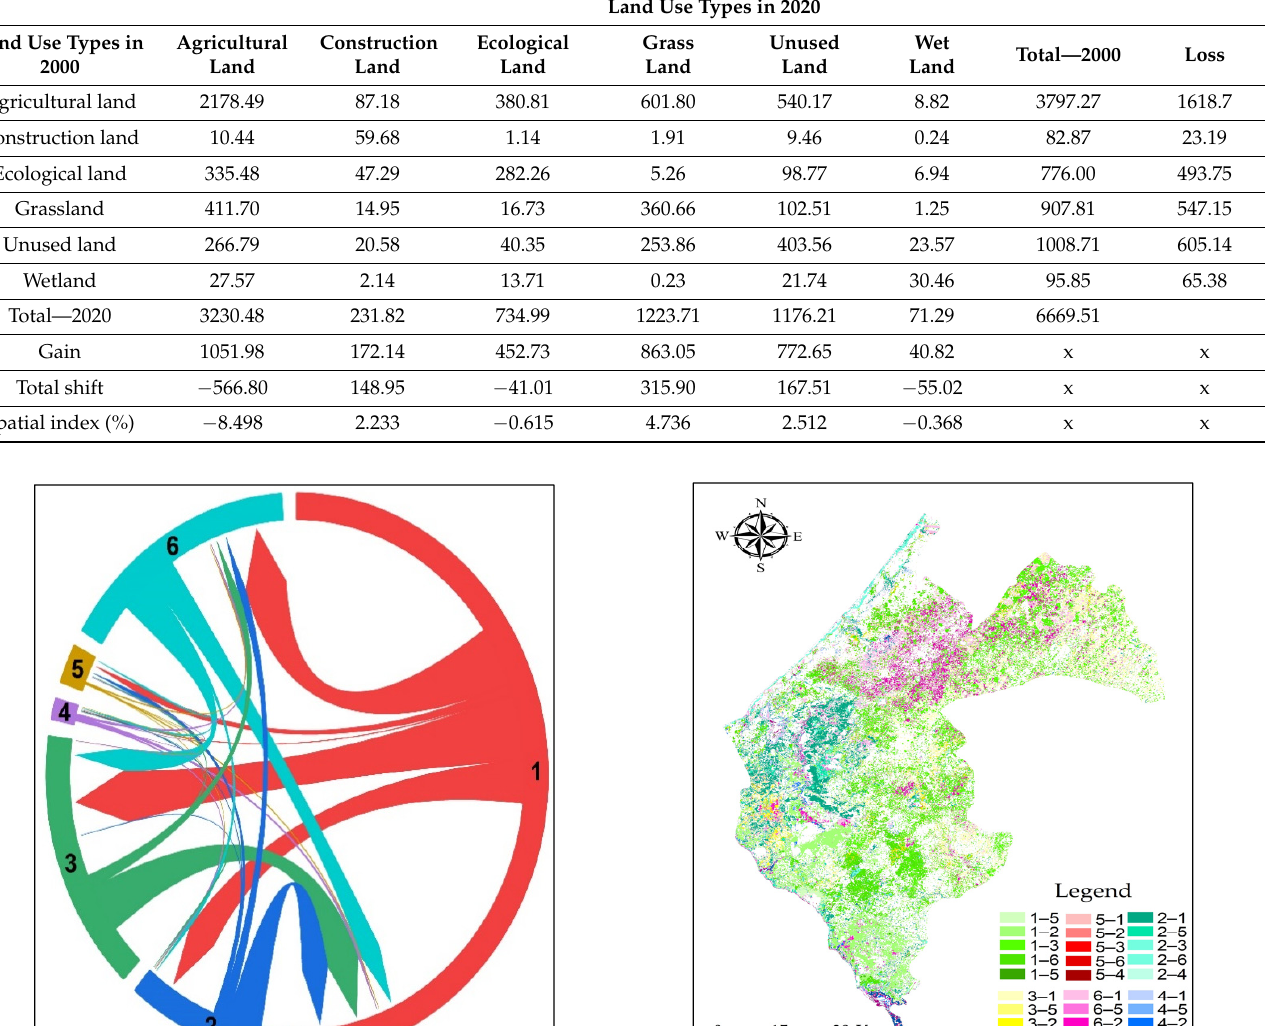
Table 5. Results of the transfer matrix of land use transition (km 2 ) in the Thi è s region, 2000 to 2020. Land Use Types in 2020